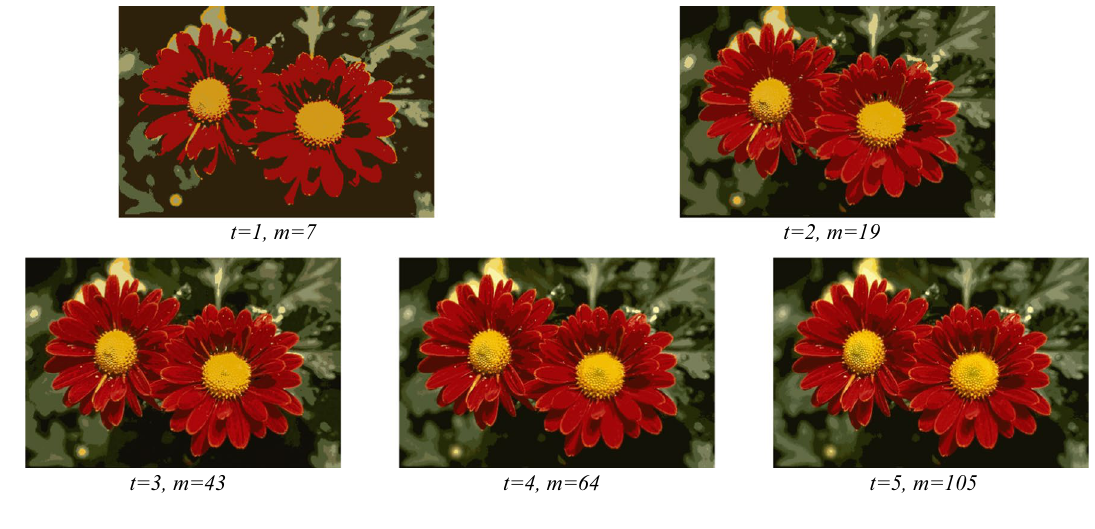
Fig. 16 Quantized 124084 image using CoG